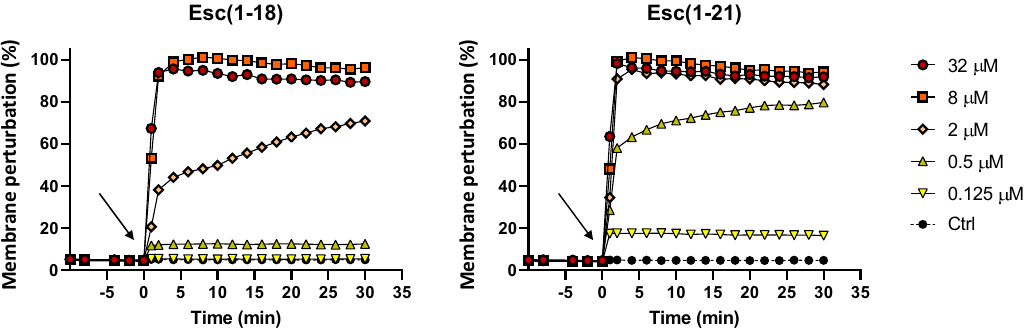
Figure 2. Membrane perturbation assay performed with the Sytox Green dye. The percentage of membrane damage was calculated with respect to the maximum membrane permeabilization obtained with the highest peptide concentration (32 µ M) and the addition of 1 mM EDTA + 0.5% Triton X-100. Arrows indicate the addition of the peptide. Data points are the mean of triplicate measurements from a single experiment representative of three independent experiments. Controls (Ctrl) are cells not treated with the